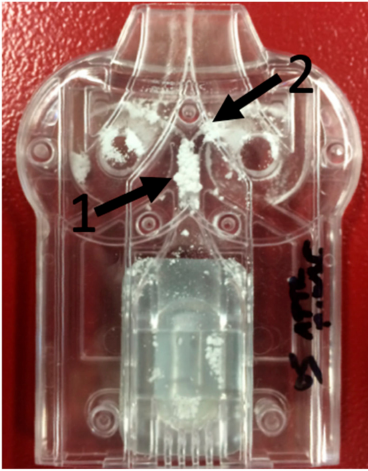
Figure 4. Representative picture of a blocked Twincer ® inhaler. Note the arrows pointing at the two areas where blockages